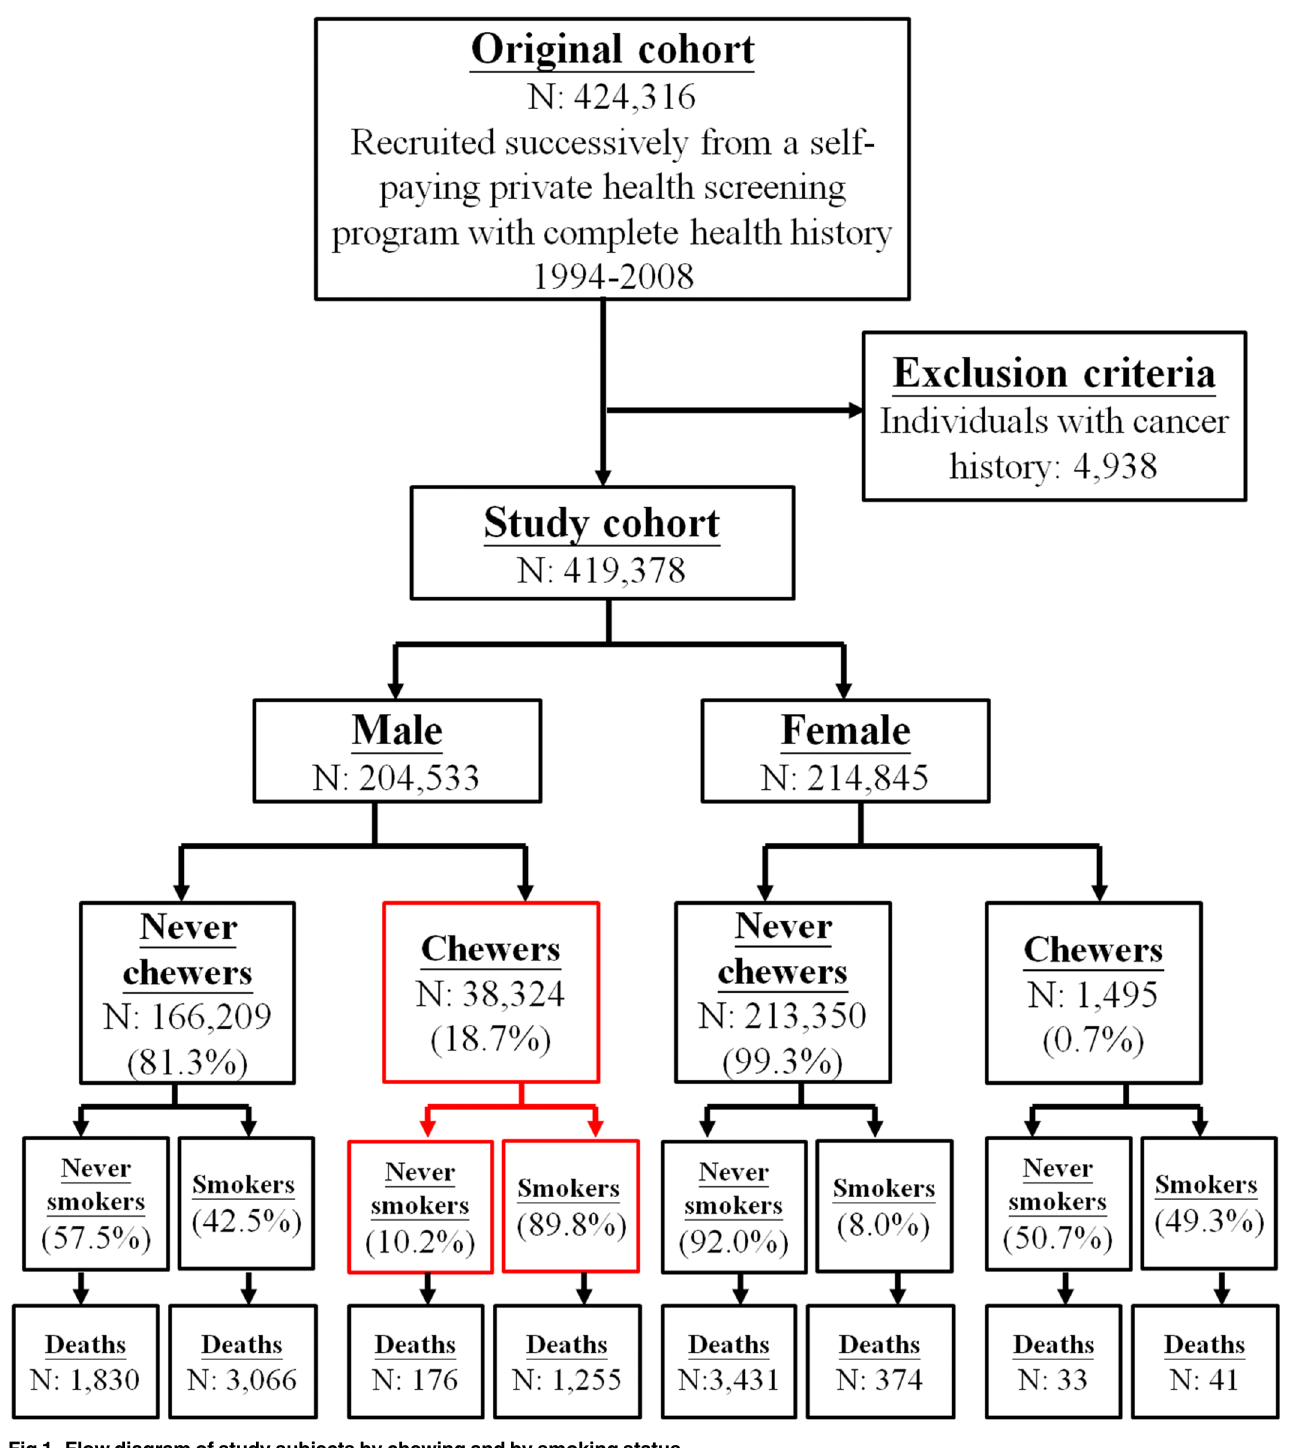
Fig 1. Flow diagram of study subjects by chewing and by smoking status.